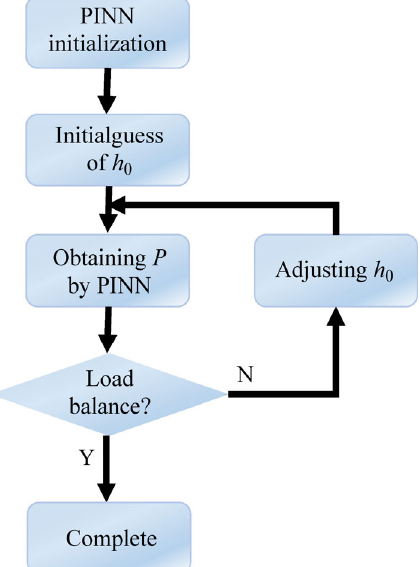
Fig. 12 Flow chart for the hydrodynamic lubrication contact.